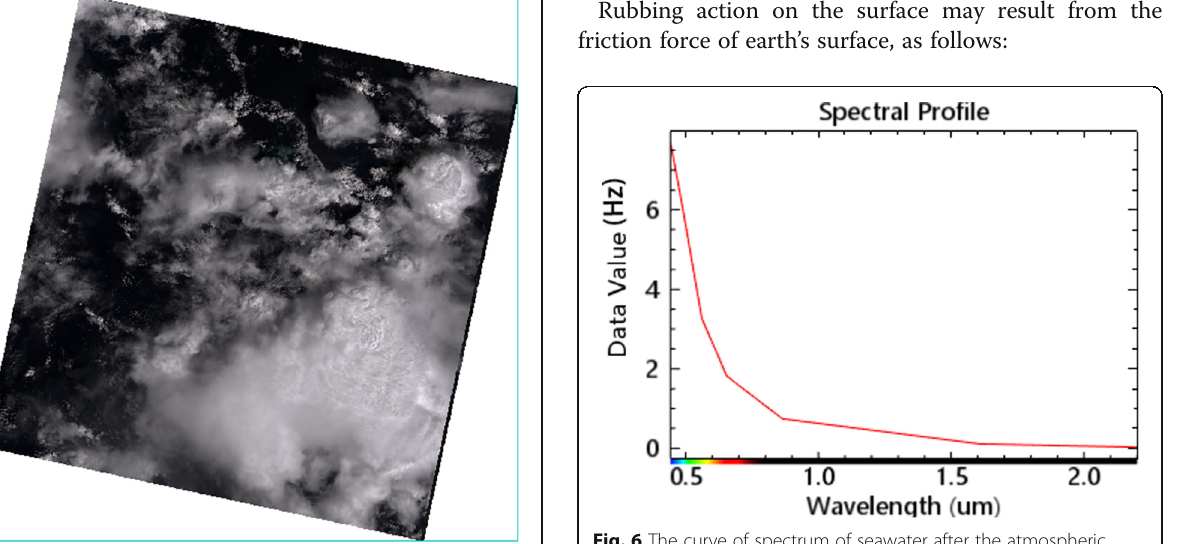
Fig. 6 The curve of spectrum of seawater after the atmospheric